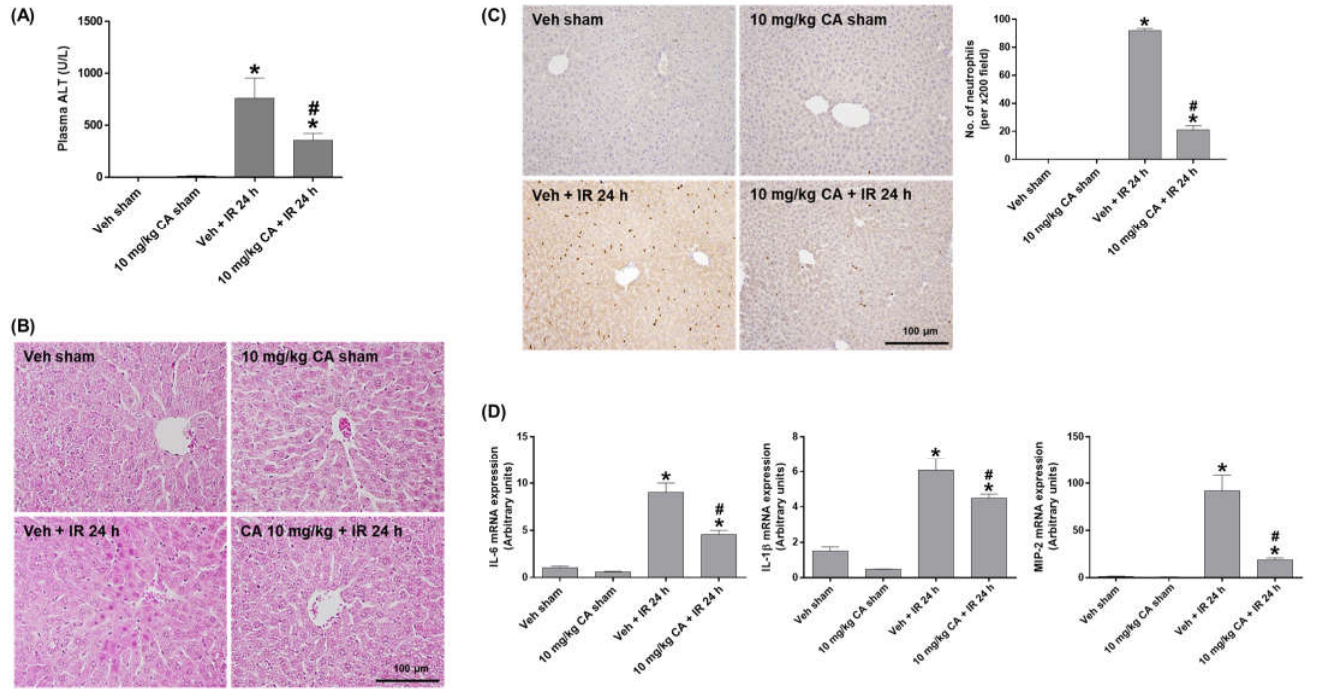
Figure 3. CA reduces hepatocellular damage, neutrophil infiltration, and inflammatory cytokines in the liver of IR mice. Plasma ALT levels ( A ). Representative images of H&E staining ( B ) and PMN staining ( C ) of liver sections; the positive cells were counted per ×200 field. Hepatic mRNA expres- sion of proinflammatory genes, IL-6, IL-1β, and MIP-2; relative mRNA levels were normalized to levels of GAPDH ( D ). The values are expressed as the means ± SEM. * p < 0.05 compared to sham group. # p < 0.05 compared to IR group.